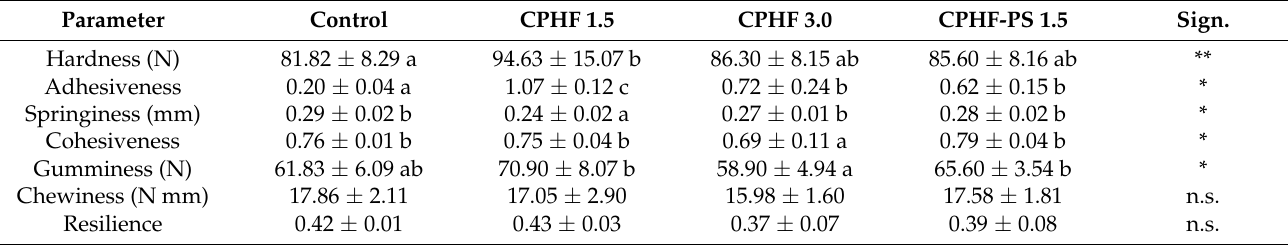
Table 5. Texture profile analysis (TPA) parameters of